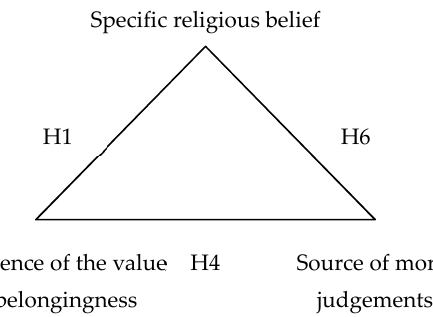
Figure 3. Relationships to sources of moral judgements.